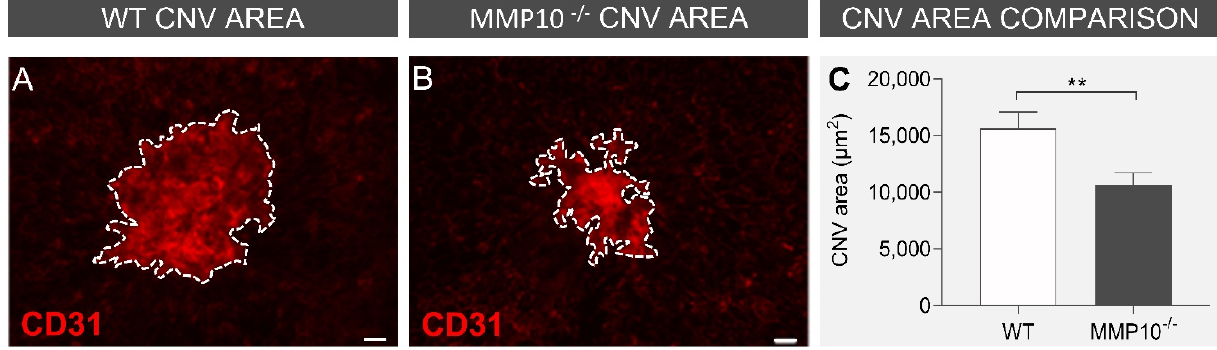
Figure 4. Endothelial cells (ECs) of laser ‐ induced CNV areas are positive for MMP10 staining. Rep ‐ resentative laser ‐ induced CNV lesions on choroidal flat ‐ mounts from WT mice stained with MMP10 (red), lectin or CD31 (green). ( A ) Whole flat ‐ mount micrograph with three successfully induced CNV around the optic nerve, the outlined region represents the CNV shown in ( B – F ). ( B ) Magnifi ‐ cation of dotted square in CNV area. MMP10 expression is increased in the CNV area. ( C ) Orthog ‐ onal view of the obtained z ‐ stack showing that MMP10 expression is localized over the RPE Upper orthogonal projection showed a RPE nuclei disorganization and right orthogonal projection showed disruption in RPE nuclei (*). ( D ) Magnification of the same CNV in which the outlined region rep ‐ resents the magnification shown in E and F. ( E ) Magnification (63×) inside the CNV area showing